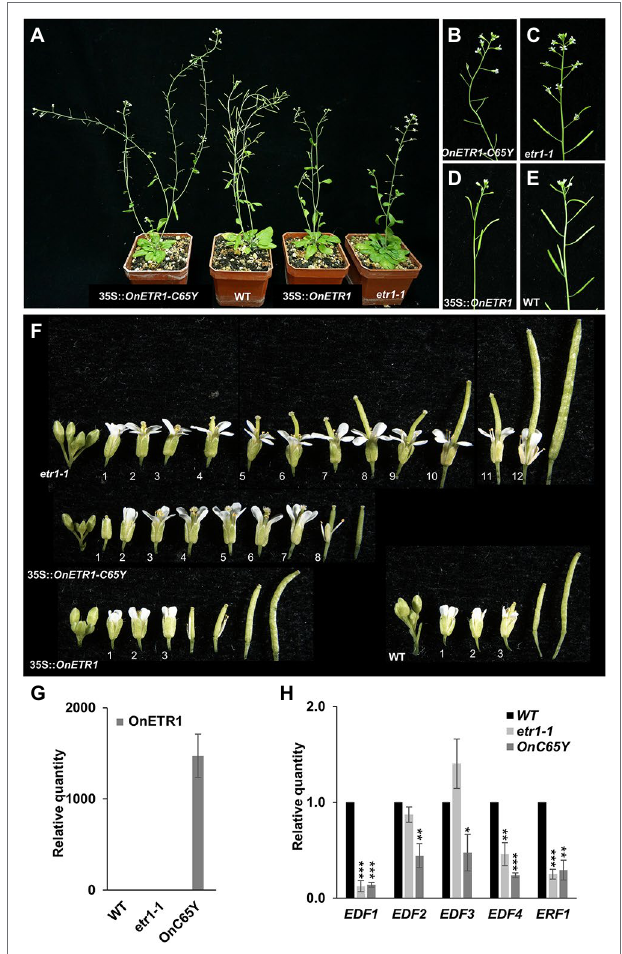
FIGURE 4 | Phenotypic analysis and detection of gene expression in Arabidopsis ectopically expressing OnETR1-C65Y . (A) Mature 35S:: OnETR1 - C65Y , WT, 35S:: OnETR1 , and etr1-1 plants (from left to right). (B–E) Close- up of the inflorescences of the 35S:: OnETR1 - C65Y (B) , etr1-1 (C) , 35S:: OnETR1 (D) , and wild-type (E) plants from (A) . (F) Flowers along inflorescences from etr1-1 , 35S:: OnETR1 - C65Y , 35S:: OnETR1 and WT Arabidopsis . The senescence and abscission of flower organs in etr1-1 and 35S:: OnETR1 - C65Y flowers were significantly delayed. The numbers indicate the positions of the flowers. (G) Relative expression of OnETR1 - C65Y in WT, etr1-1 and 35S:: OnETR1-C65Y transgenic Arabidopsis based on real-time quantitative PCR. (H) Relative expression of the downstream ethylene signaling genes EDF1-4 and ERF1 in WT, etr1-1 and 35S:: OnETR1-C65Y transgenic Arabidopsis based on real-time quantitative PCR. The transcript levels of these genes were determined using two to three replicates and were normalized to UBQ10 . The expression of each gene in the transgenic plants is given relative to that of the wild-type plant, which was set at 1. The error bars represent SDs. The asterisks indicate a significant difference from the WT value (* p < 0.05; ** p < 0.01; and *** p < 0.001). Statistical analysis was conducting using two-tailed Student’s t